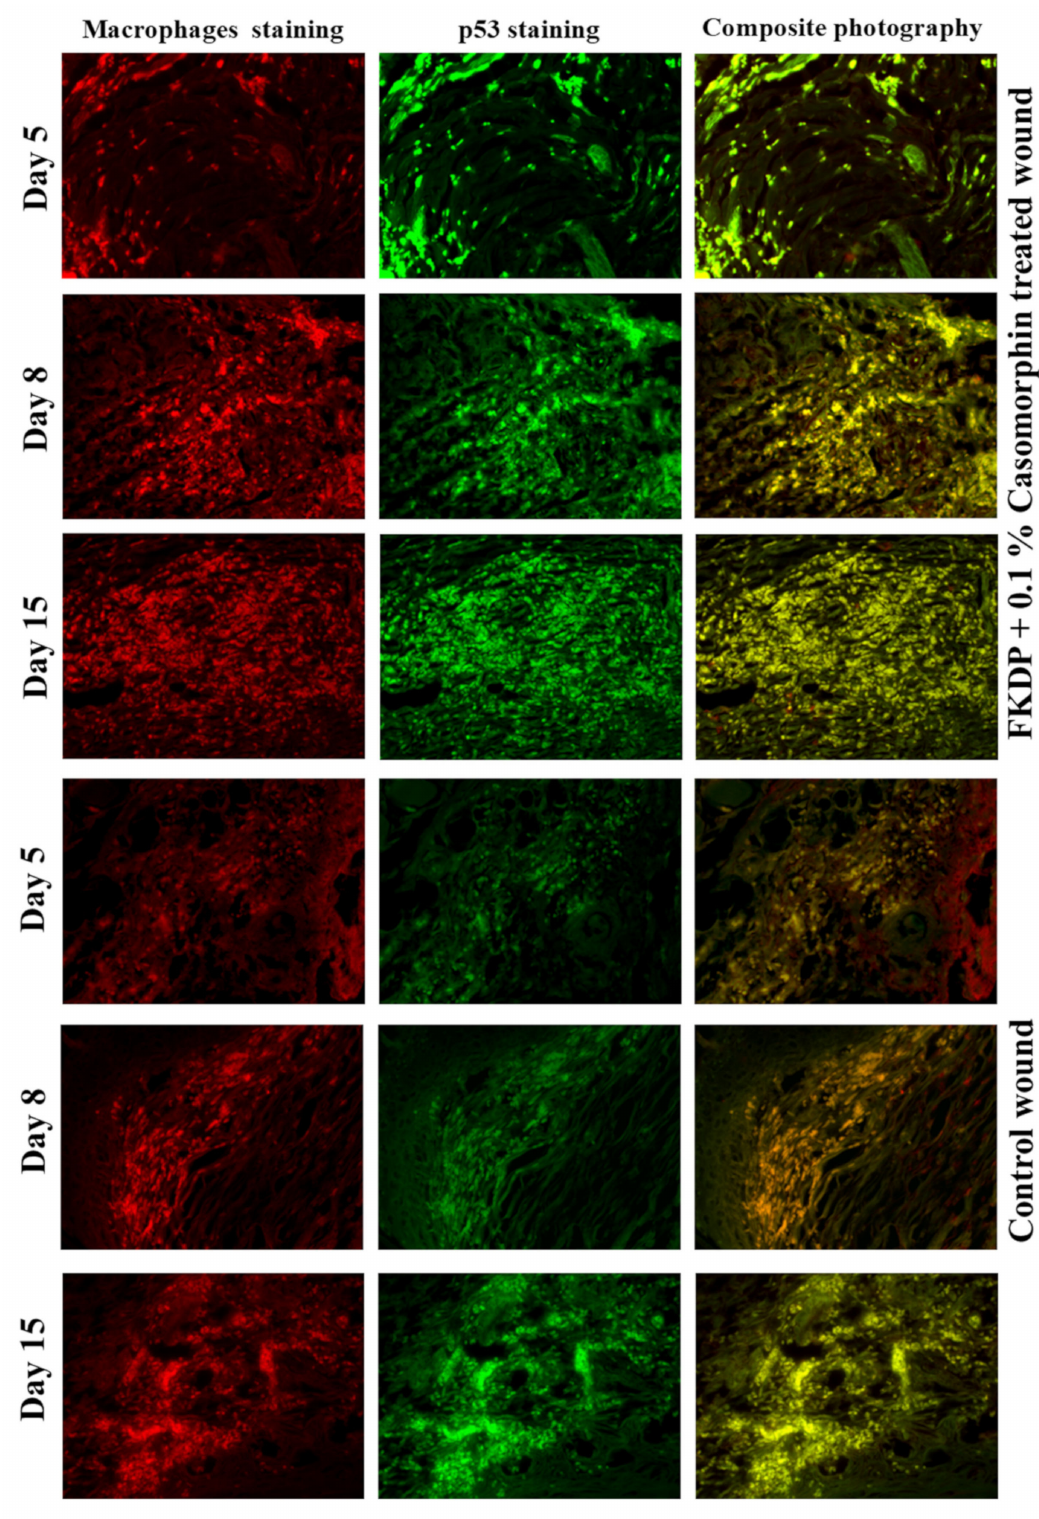
Figure 5. Tissue biopsy taken from FKDP + 0.1%Caso (3 upper panels) treated wound and control wound (lower panel) immunolabeled for macrophages (red), p 53 (green). Note the changes in immunoreactive cell numbers during the healing course (color online, black & white in